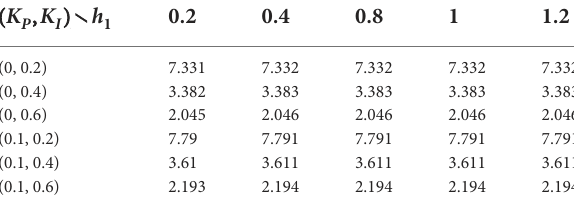
TABLE 4 MADUBs h 2 for μ = 0 and various h 1 under theorem 1.